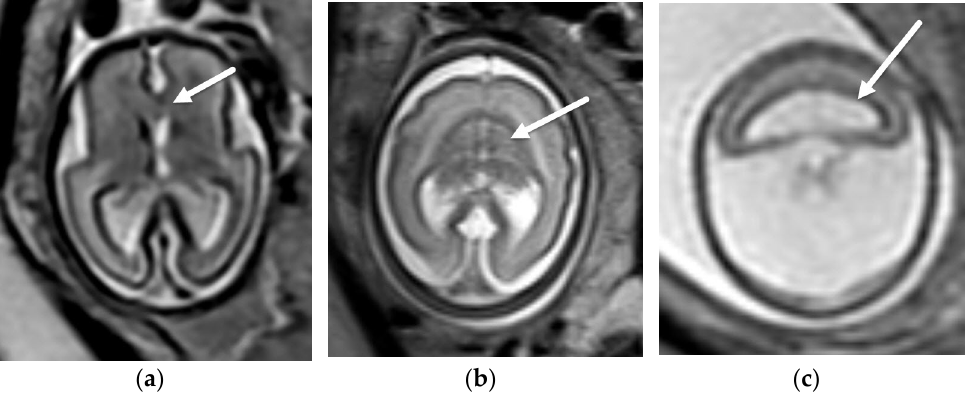
Figure 5. Holoprosencephaly spectrum. Axial T2-SSFSE images of the brain in fetuses with holo- prosencephaly spectrum. Fetal MRI of a fetus with lobar holoprosencephaly at 24 weeks and 2 days GA ( a ) demonstrates near complete separation of the cerebral hemispheres with a small area of incomplete separation (arrow) in the frontal lobes. Fetal MRI of a fetus with semi-lobar holopros- encephaly at 24 weeks and 2 days GA ( b ) demonstrates absence of normal separation of the frontal lobes, basal ganglia and thalami (arrow). Fetal MRI of a 21-week GA fetus with alobar holoprosen- cephaly ( c ) demonstrates complete absence of normal separation of the cerebral hemispheres with a monoventricle (arrow).